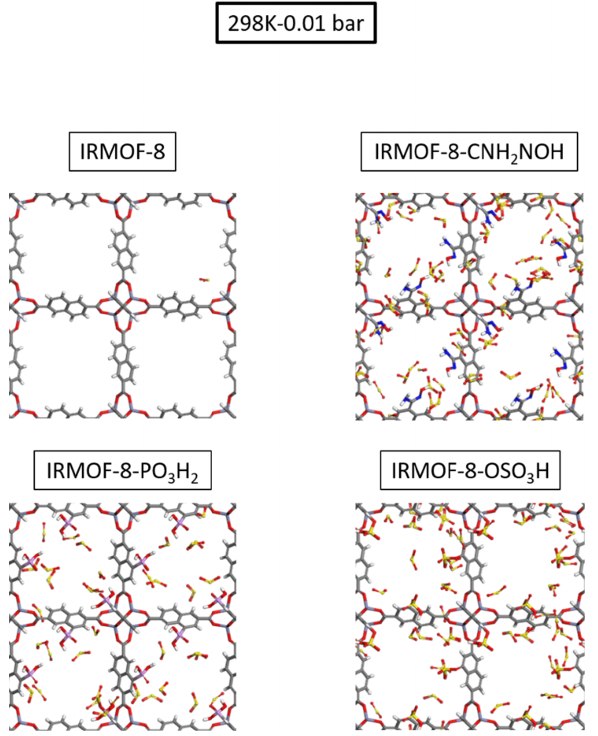
Figure 6. Snapshots of IRMOF–8, IRMOF–8–OSO 3 H, IRMOF–8–PO 3 H 2, and IRMOF–8–CNH 2 NOH taken from our GCMC simulations at 298 K and 0.01 bar.